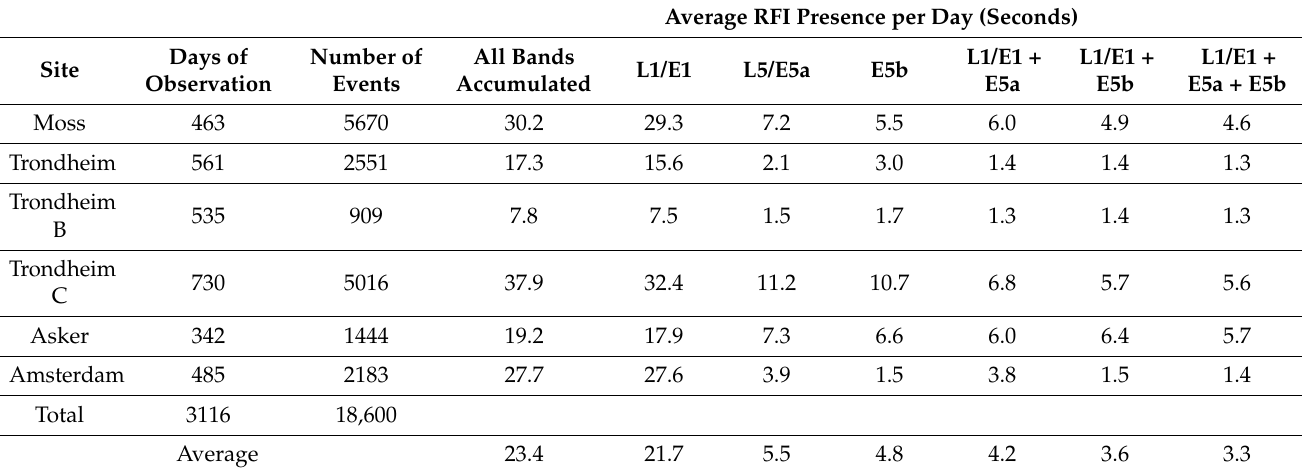
Table 3. Site activity summary considering the L1/E1, E5a and E5b frequency bands.